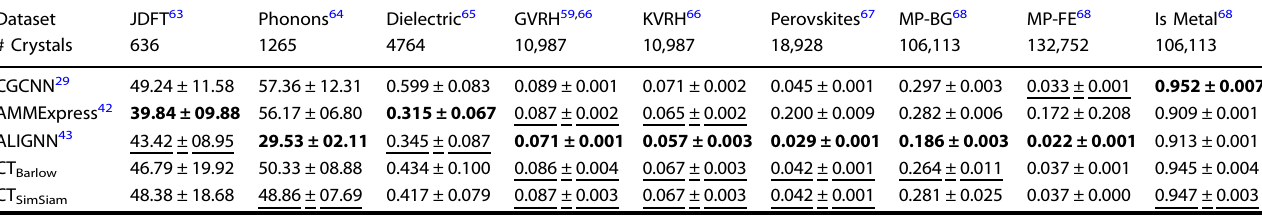
Table 2. Mean and standard deviation of test MAE of Crystal Twins (CT) in comparison to the supervised baselines on MatBench 42 regression benchmarks.